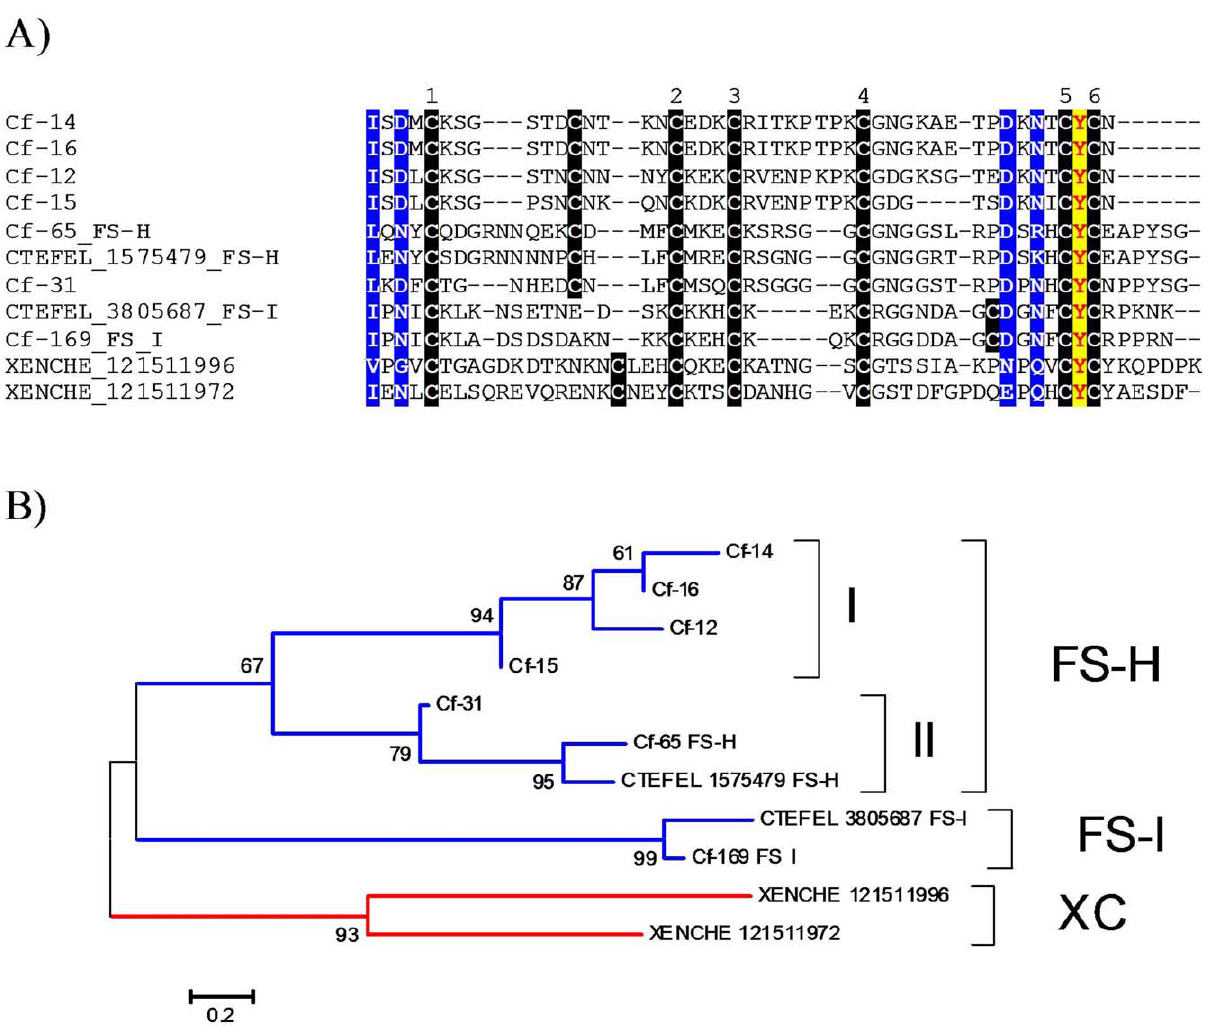
Figure 3. The FS-H/FS-I/7-Cys family of flea salivary peptides. (A) ClustalW alignment indicating the cysteine residues in black background, the identical Tyr in yellow background, and the conserved amino acids in blue background. The numbers above the sequence indicate the six conserved cysteines. The signal peptide region is not shown. (B) Bootstrapped phylogram of the sequences based on the alignment in (A) after 1,000 iterations. The numbers at the nodes indicate the percent bootstrap support, and the bar at the bottom the amino acid divergence per site. Sequences identified in this work are named Cf- followed by the number of the originating contig from File S1. Sequences derived from GenBank are recognized by the first three letters of their genus name, followed by the first three letters of the species name, followed by the gi| accession number. The cat flea proteins giving the name of the family are indicated by FS-H and FS-I following their accession numbers.